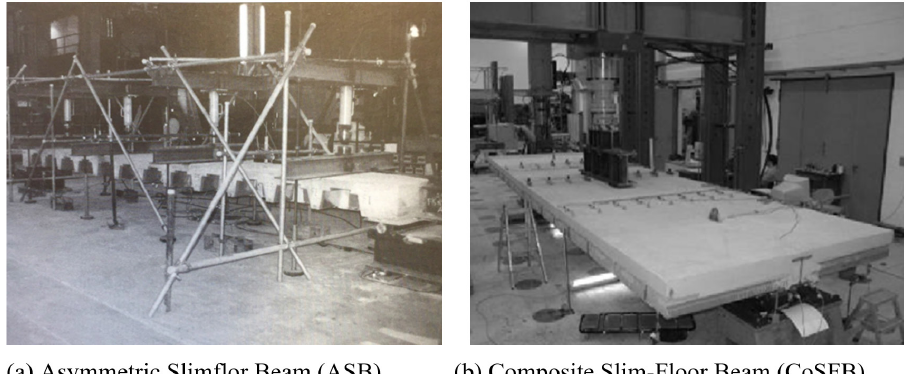
Figure 6. Loading condition of experimental